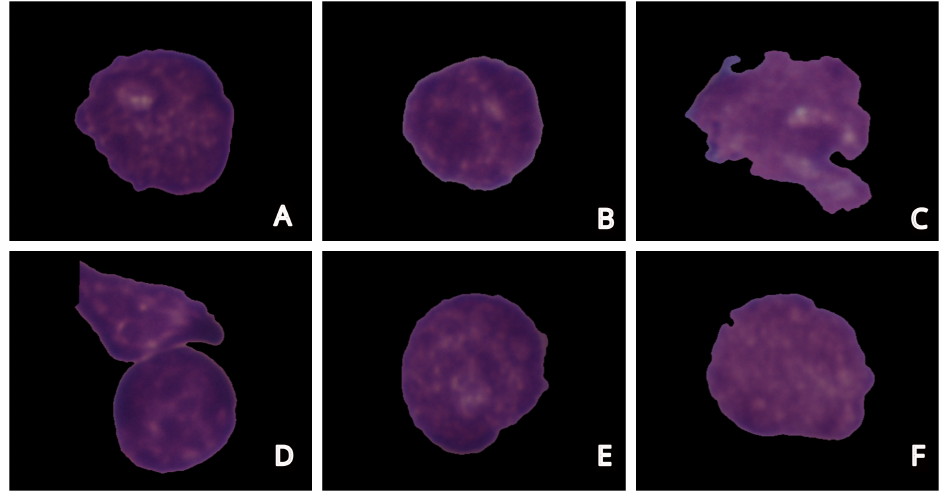
Figure 1. ALL cell image samples from C-NMC 2019 dataset [8–12]. Images ( A – C ) show ALL cancer cell images while ( D – F ) show healthy cell